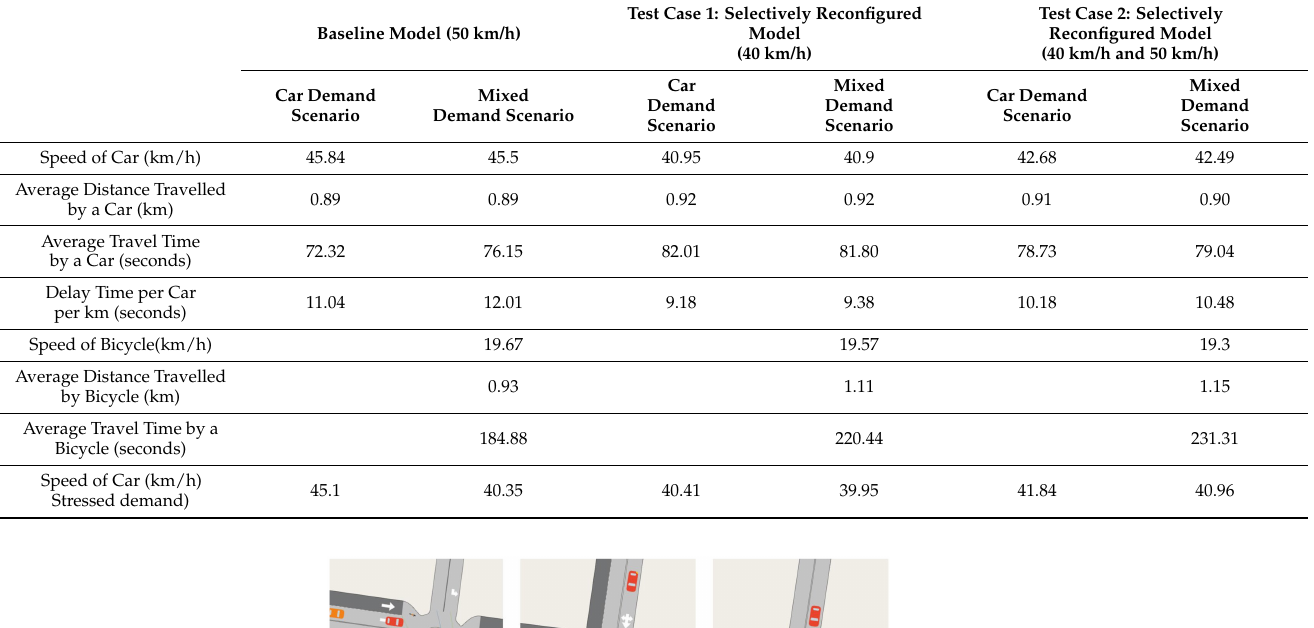
Table 2. Summary of simulation results.